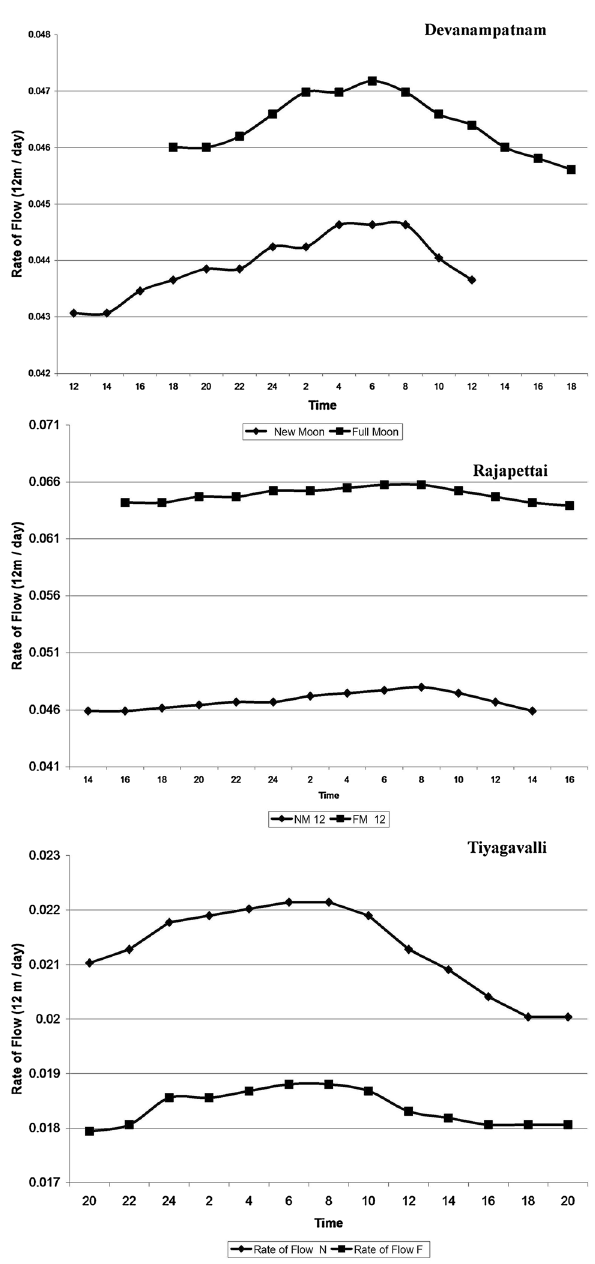
Fig. 8 Variation in Rate of flow during FM and NM at